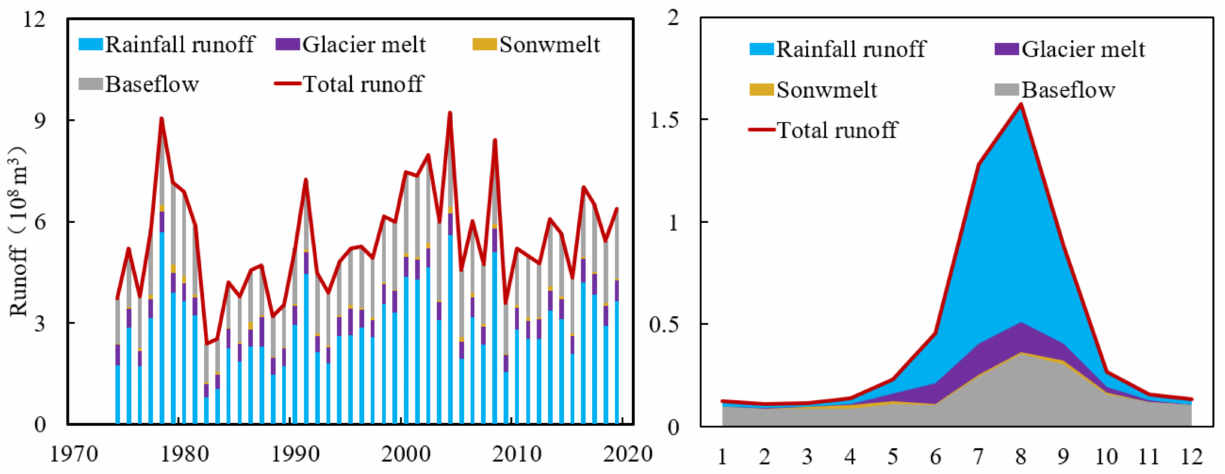
Figure 11. Annual and intra-annual variations of runoff and its components of Yamzho Yumco lake